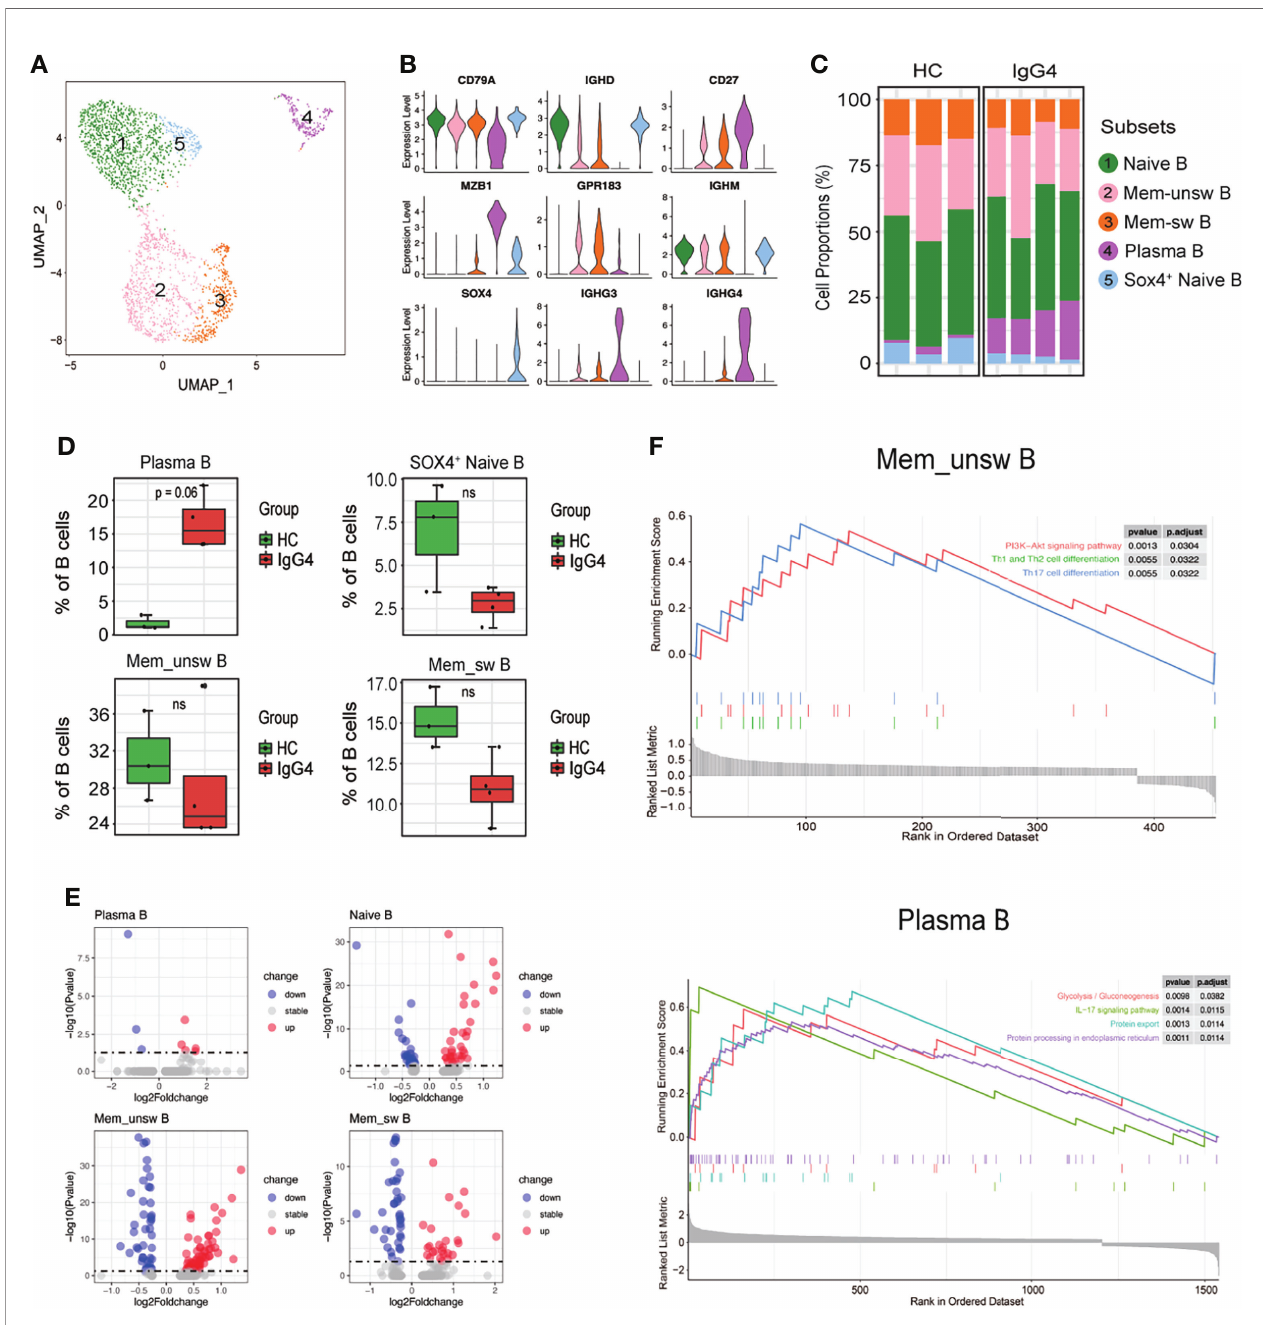
FIGURE 2 | The heterogeneity and transcriptional features of B-cell subsets in IgG4-RD. (A) UMAP representation of 2,449 B cells, showing the formation of fi ve clusters. (B) Violin plots showing expression distribution of canonical cell markers. (C) Bar plot showing cluster abundance of each B-cell type across all samples. (D) Percentages of four types of B-cell between HCs and patients with IgG4-RD. The y -axis shows the average percentage of B-cell subtypes in total B cells. Error bars are shown in mean ± SEM. Student t -test was used for the analysis, and P < 0.05 is considered as a signi fi cant difference, ns stands for nonsigni fi cant. (E) Volcano plot showing the DEGs of B-cell subtypes between HCs and patients with IgG4-RD. (F) GSEA results showing the signi fi cantly enriched pathways in Memory-unswitched (Mem-unsw) B cells and Plasma B cells of patients with